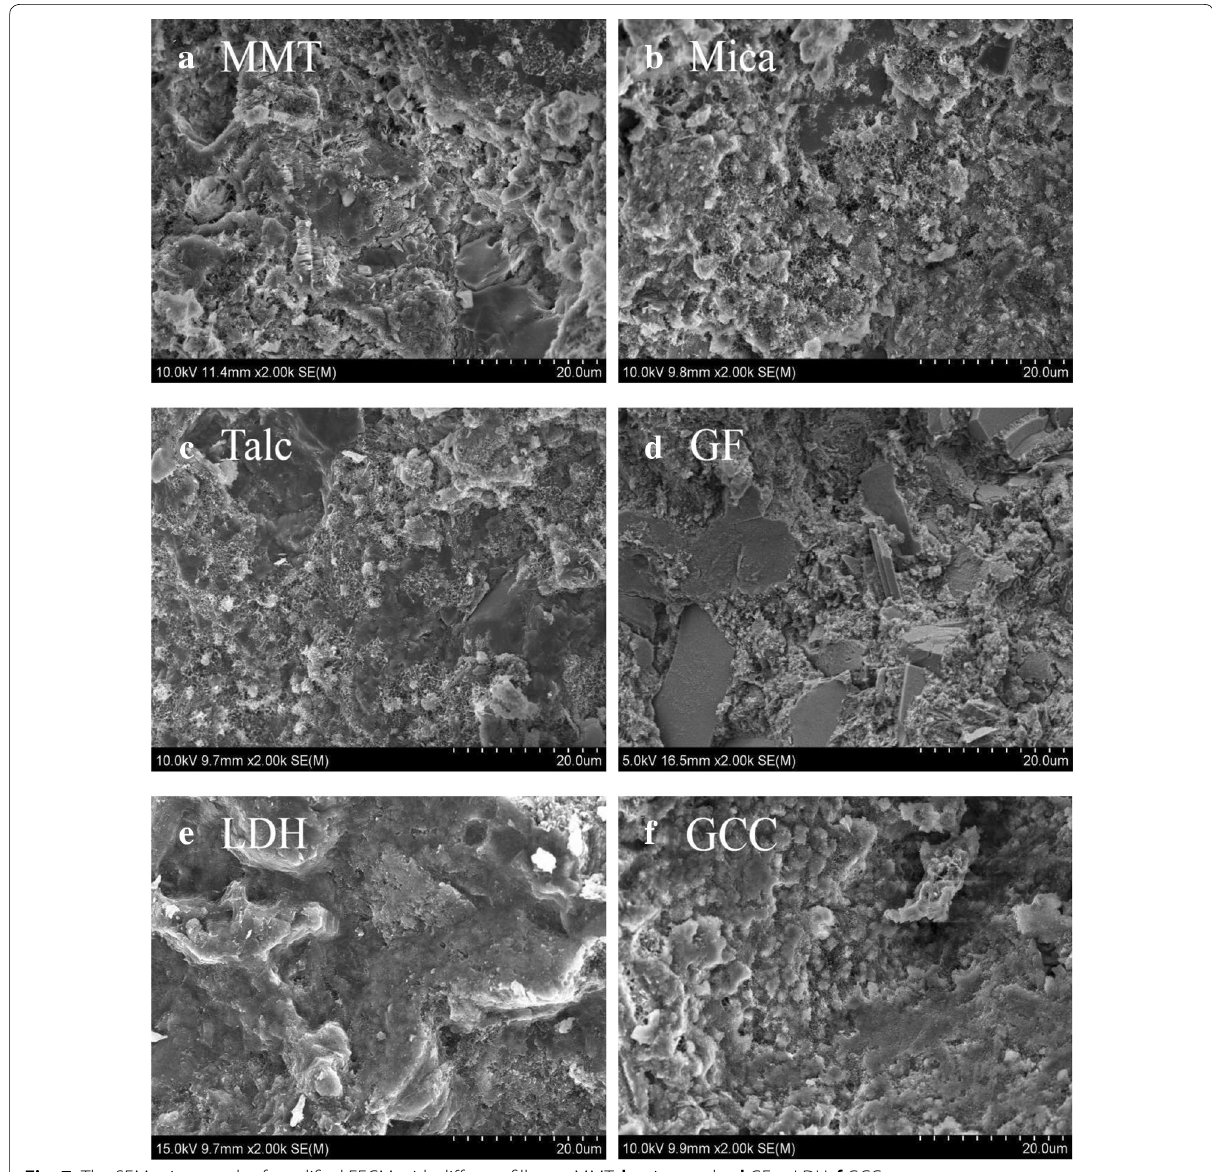
Fig. 7 The SEM micrograph of modified EECM with different fillers. a MMT; b mica; c talc; d GF; e LDH; f